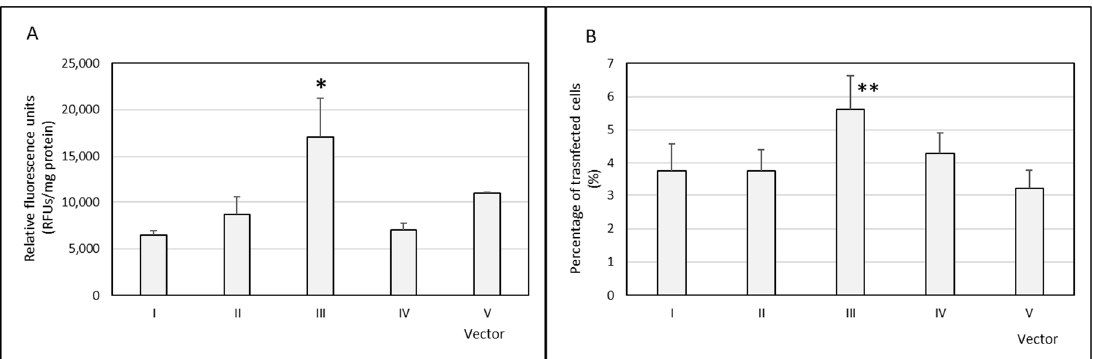
Figure 3. The transfection efficacy of the vectors in human corneal epithelial (HCE)-2 cells. ( A ) Relative fluorescence units per mg of protein (RFUs/mg protein) of the transfected cells. ( B ) Percentage of transfected cells ( n = 4). Data are expressed as mean ± standard deviation. * p < 0.05 with respect to the other formulations. ** p < 0.05 with respect to formulations I, II, and V.